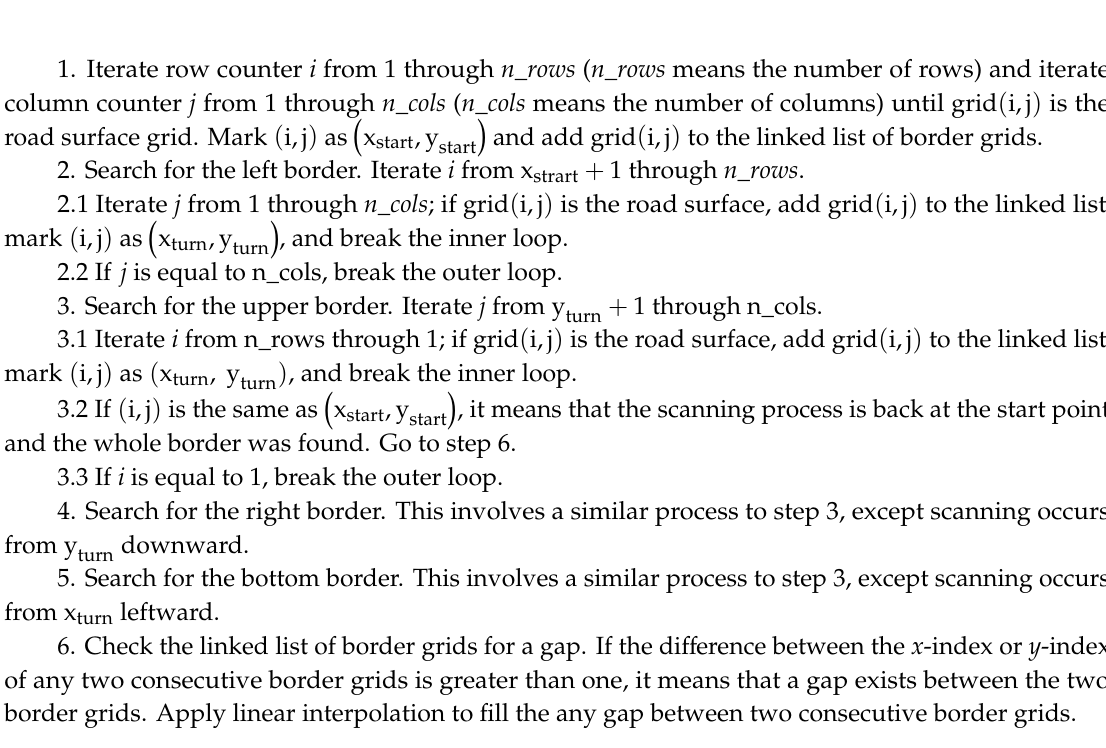
Figure 9. Schematic diagram of searching for border grids. Arrows label the checking directions and all the grids checked, circles mark the border, and crosses represent the interpolated grids for gaps.